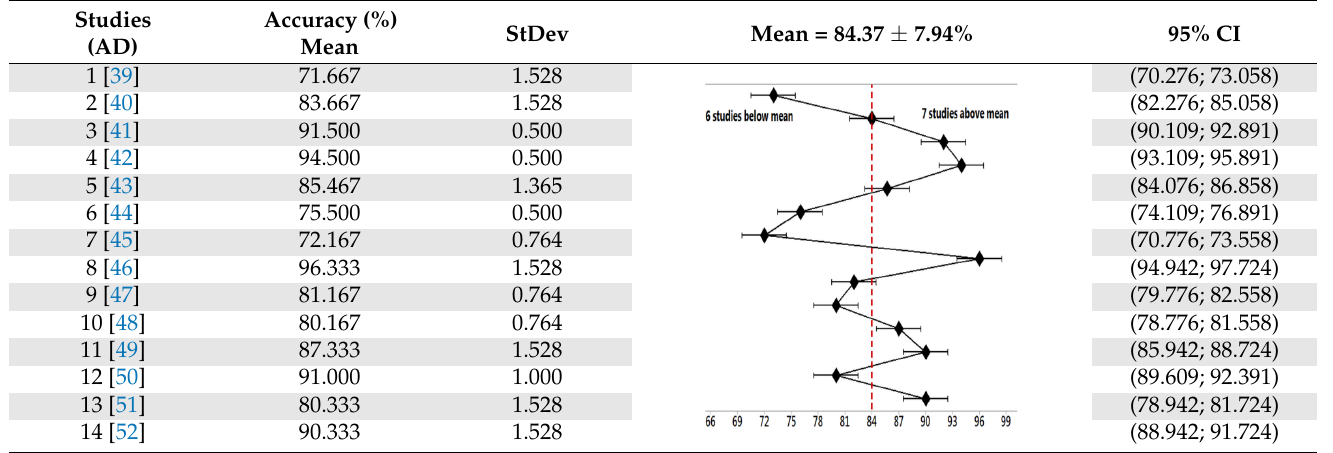
Table 6. Tukey's statistical analysis among studies with the highest accuracy (%), with p > 0.05 at 95% CI. The study groups presented these results with the same